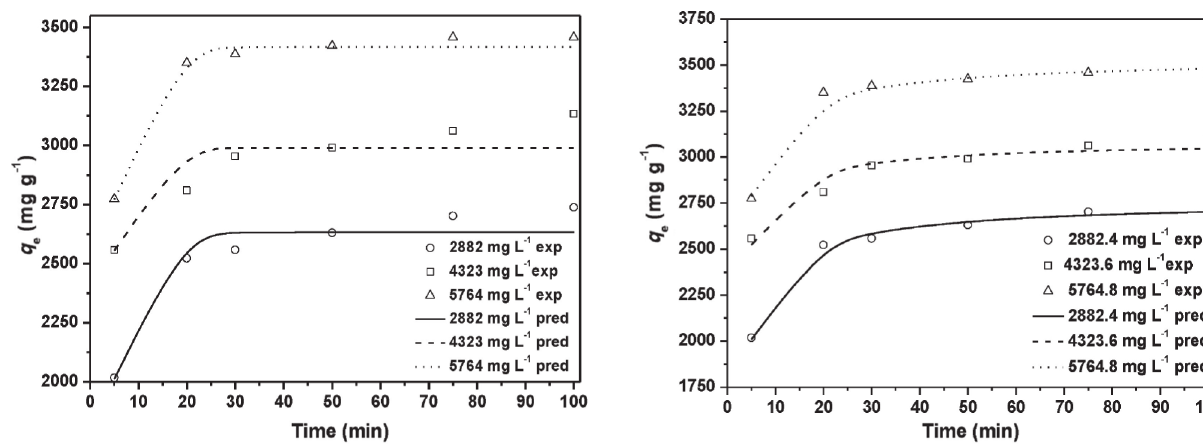
Fig. 10 – Pseudo-second-order kinetic fit for adsorption of nanoparticles (initial acrylic acid concen- acrylic acid onto CaO 2 tration = 2882, 4323, 5764 mg L –1 , adsorbent dosage = 1 g L –1 , time = 125 min, and temperature = 300.15 K)